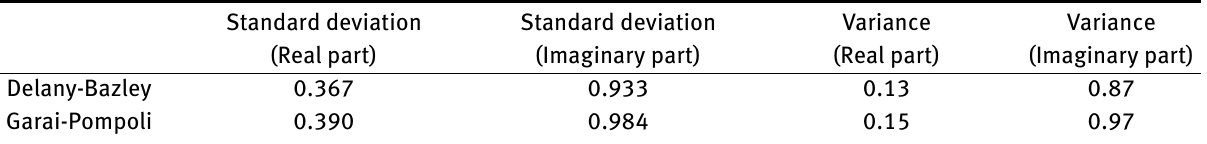
Figure 7: Normalized impedance (a) and absorption coeflcient (b) curves for un-faced absorbing material Table 2: Summary of the models’